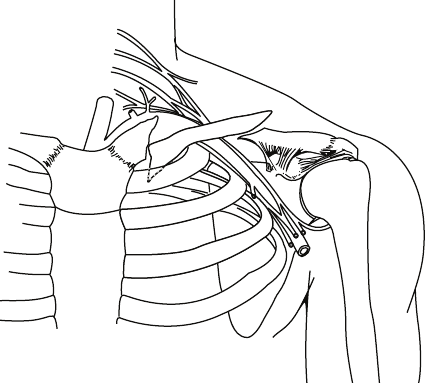
Figure 1: Drawing based on the first post-injury radiograph taken of the patient’s left clavicle. This shows the double fracture pattern: a medial nonunion with an inferiorly directed spike of bone and an acute lateral fracture. The inferiorly directed spike of the medial fracture was in close proximity to the lung apex. The actual radiograph could not be used to provide this illustration because of water damage.